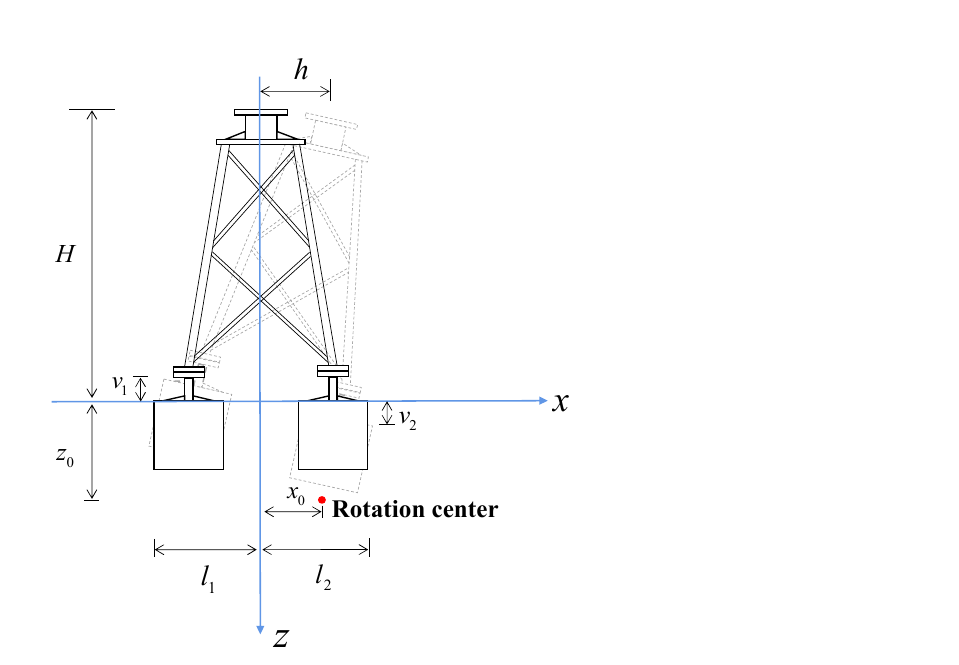
Figure 7. Coordinate system and parameters for determining the position of rotation center. Figure 8 gives a comparison of the trajectory of the instantaneous rotation center for the foundation under two loading conditions (namely, OBT and TBT). The variation of the rotation center in two opposite loading directions obeys a similar evolution law. At the early stage of loading, the rotation center is located below the bottom of the foundation and close to the windward bucket. The rotation center gradually moves towards the leeward bucket along the loading direction with the increase in lateral load, and its vertical position is also closer to the ground surface. It shows that the foundation experiences a rotational displacement accompanied by a forward translational movement. At the end of the loading stage, the center of rotation is transferred into the front bucket, with a failure of the foundation witnessed.